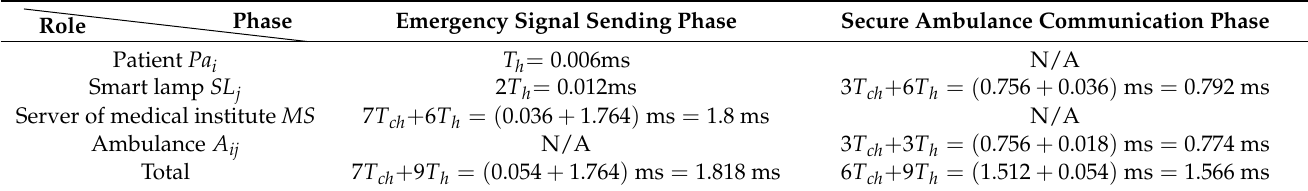
Table 3. Performance analysis of proposed